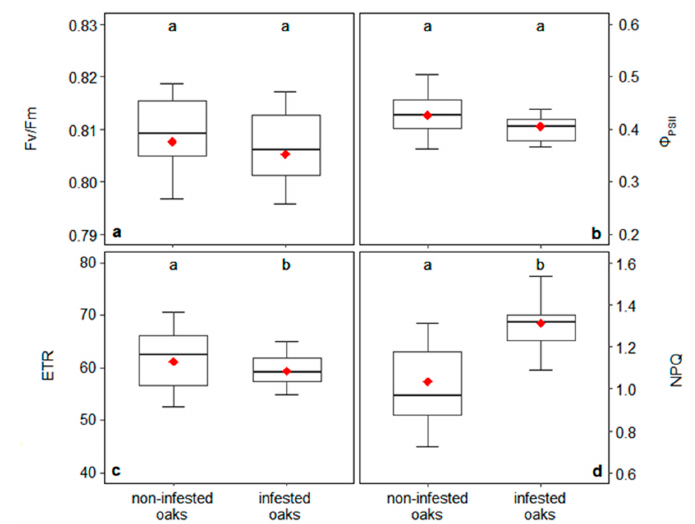
Figure 3. The maximal efficiency of the PSII photochemistry (Fv/Fm, ( a )), actual efficiency of the PSII photochemistry ( Φ PSII, ( b )), electron transport rate (ETR, ( c )) and non-photochemical quenching (NPQ, ( d )) of non-infested oaks and infested oaks. The median (black line), 25% quantile (box; 37.5–62.5%), 50% quantile (whiskers; 25–75%) and mean (red diamond) are displayed. Lowercase letters represent statistical significance at the level of p = 0.05. Water 2020 , 12 , x FOR PEER REVIEW